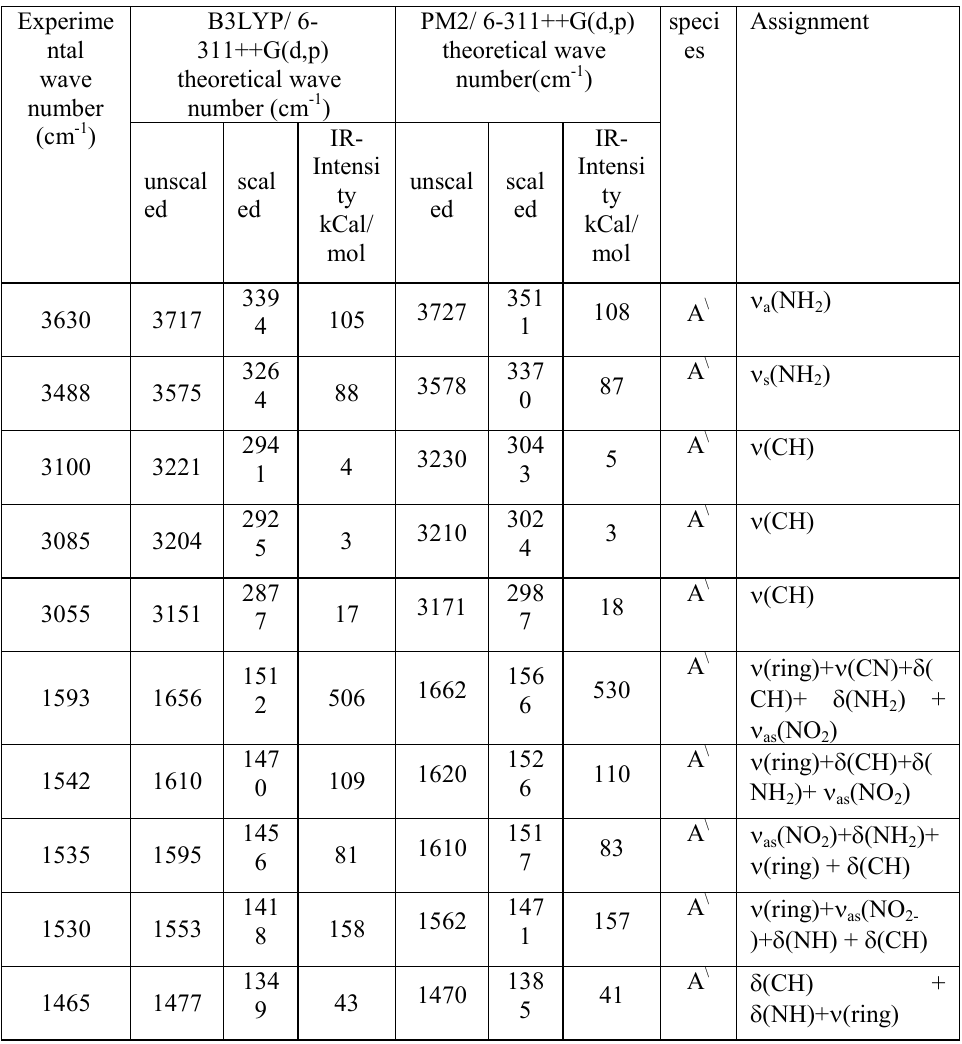
Table 3 . Experimental and B3LYP level computed vibrational frequencies (cm -1 ) obtained for